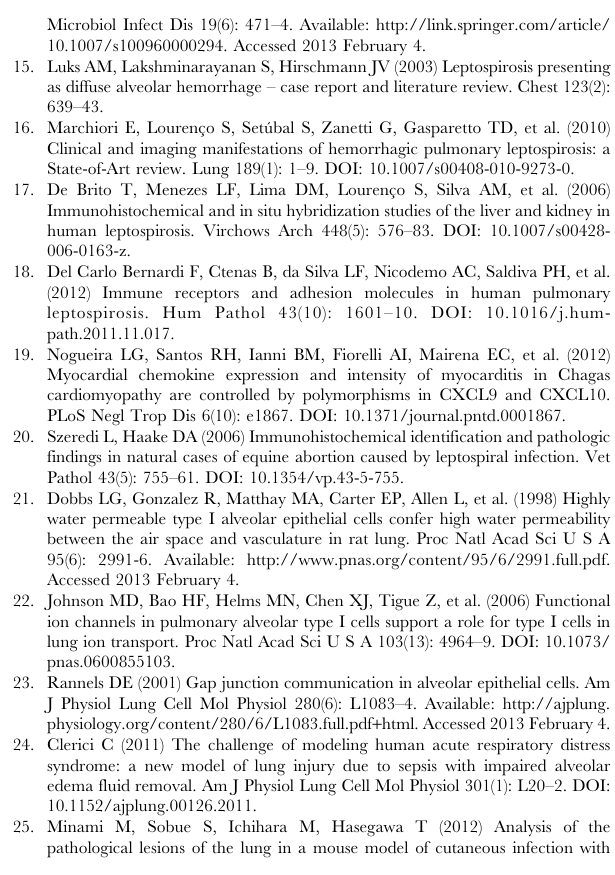
Figure 3. Immunohistochemical and confocal analysis of microcirculation of leptospirotic lungs: A: Connexin 43 is expressed in cells of the alveolar epithelial lining of a normal human lung. IHC, DAB. B : Lung in human leptospirosis. Connexin 43 is expressed both in pneumocytes of the epithelial lining and in those inside area of alveolar edema. Capillary with partial expression of CD34 in the endothelial membrane(long arrow) and a gap are present in the alveolar epithelium (short arrow). IHC, double labelling. C : Lung in human leptospirosis: Connexin 43 is expressed in the cytoplasm of isolated pneumocytes of the alveolar epithelial lining. CD34 is expressed in the capillary membranes. The short arrow and arrow head show apparently preserved capillary junctions. The long arrow points to a dilated capillary with reduced CD34 expression. Alveolar lumen is filled with plasma material and shadows of structures that might be interpreted as red blood cells. IHC, double labelling. D : Lung in human leptospirosis: Preserved expression of connexin 43 in groups and/or isolated pneumocytes. CD 34 shows an area with an almost complete lack of expression in the capillary membrane (long arrow) and irregular expression in the other capillaries. IHC, double labelling. E : Confocal microscopy of normal lung. The capillary walls are delineated by immunofluorescence. CD34 expression. F : Confocal microscopy in the human lung in leptospirosis: A few segments of capillary walls are delineated by immunofluorescence. CD34 expression. G : Confocal microscopy of normal human lung. Aquaporin 1 appears as fluorescent granules, probably in the cytoplasm of endothelial cells. H : Human lung in leptospirosis. Endothelial fluorescent granules are still present, probably in the cytoplasm of endothelial cells.